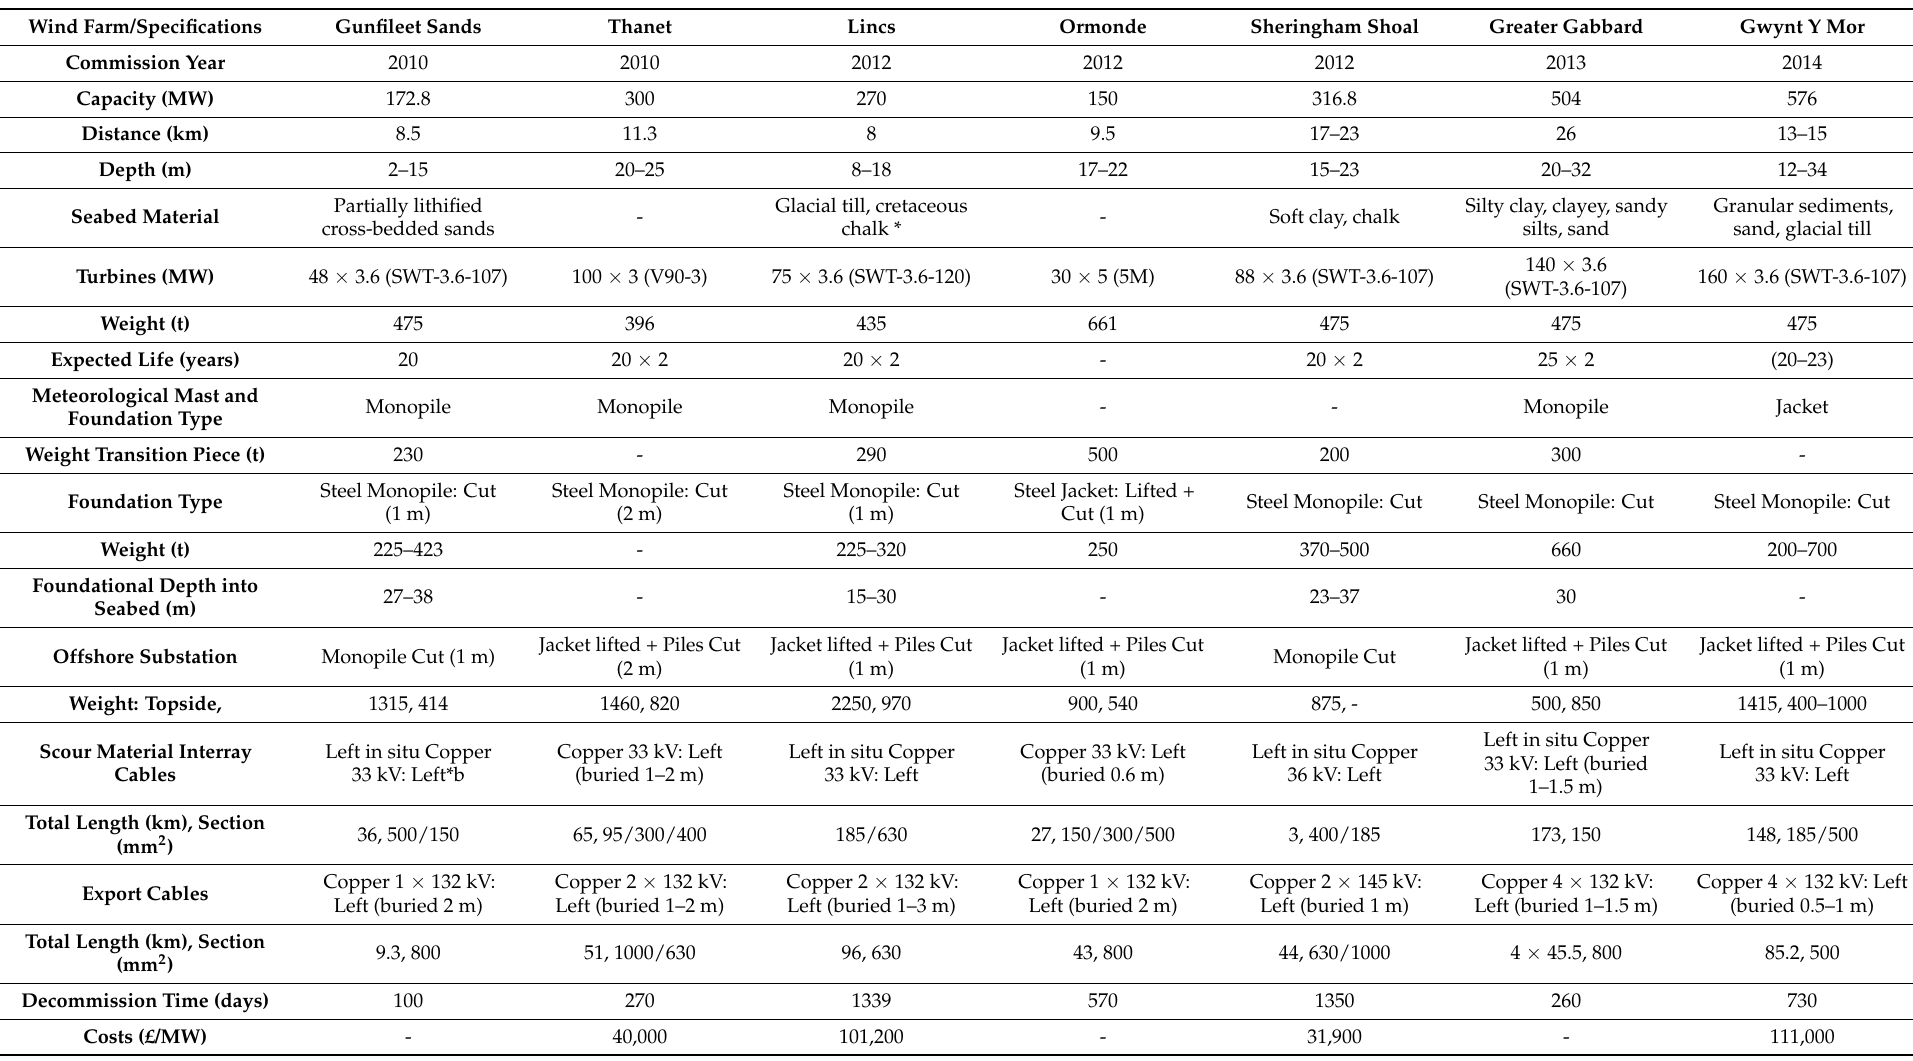
Table 2. Summary table of the decommissioning